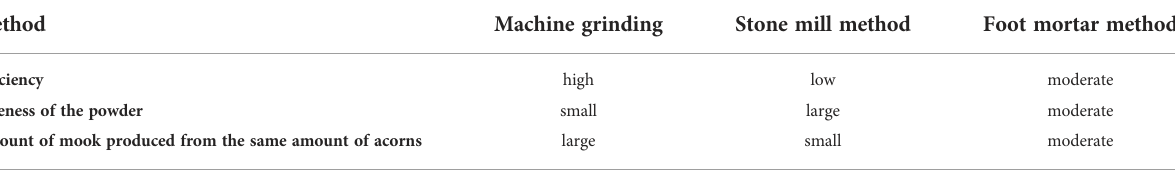
TABLE 1 Comparison of three types of grinding methods.